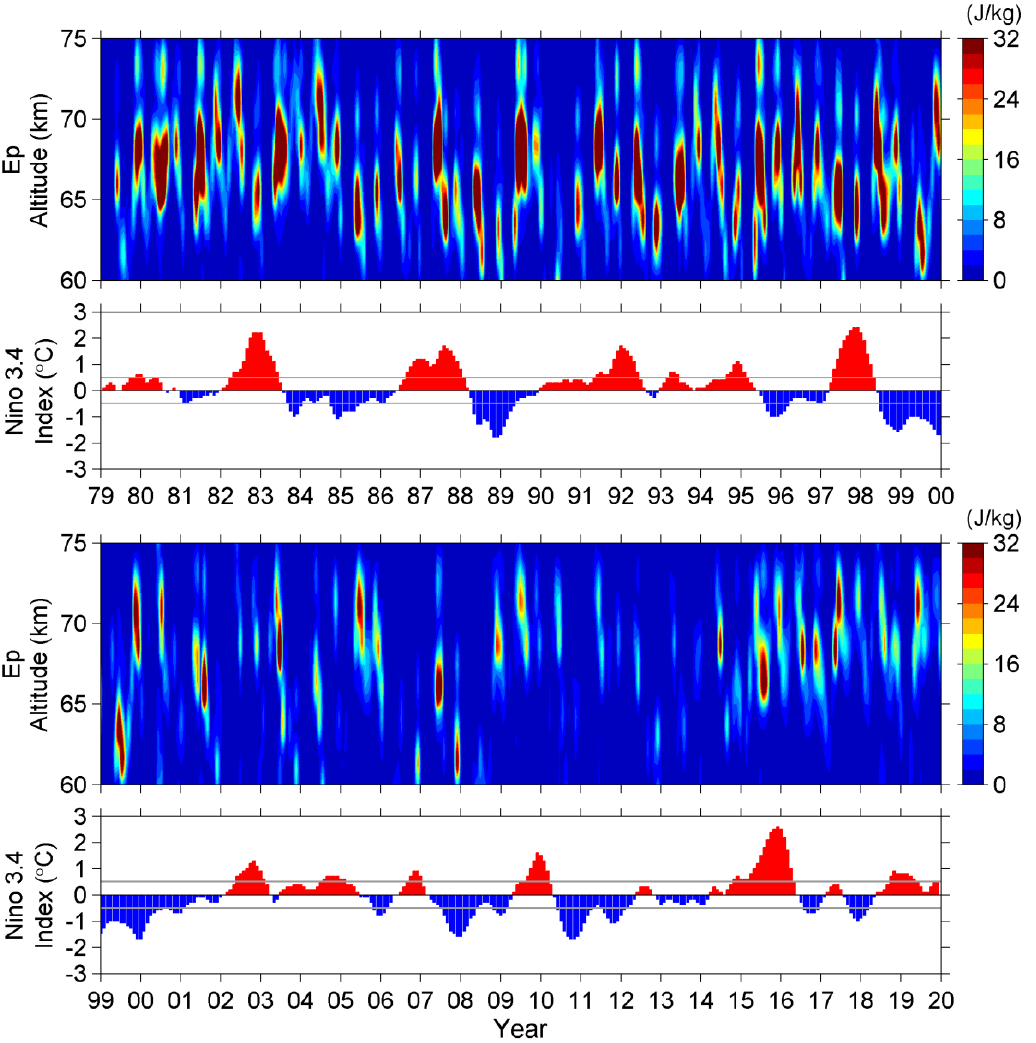
Figure 3. The first and the third panels plot the zonal mean E P at 60–75 km altitude. The second and the fourth panels plot the Niño 3.4 index, and positive/negative values are stained with red/blue respectively. The two gray lines at ±0.5°C indicate the thresholds of El Niño and La Niña events, respectively.